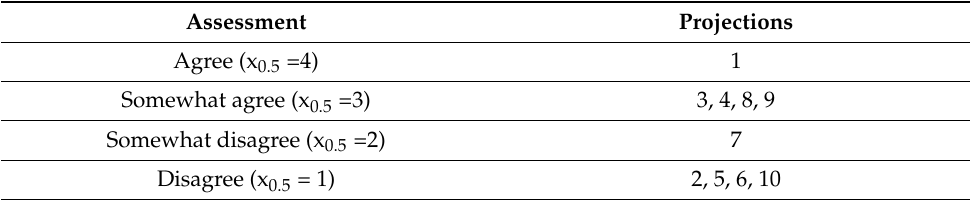
Table 3. (Dis)agreement with